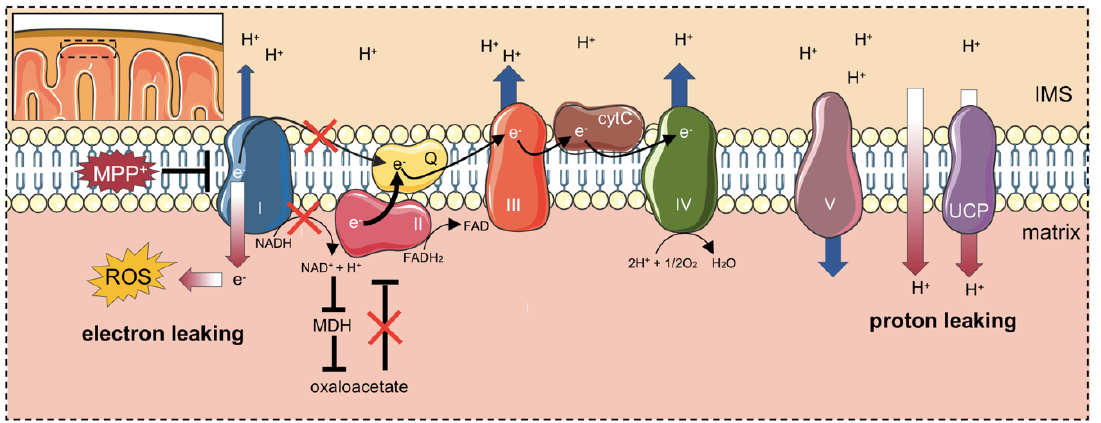
Figure 7. Proposed mechanism of MPP + toxicity at the IMM level. MPP + promotes the impairment of complex I activity. Electrons are then addressed towards other substrates, increasing ROS production (electron leaking). The reduced activity of complex I affects MDH activity as well as the accumulation of the Krebs cycle intermediates and complex II inhibitor oxaloacetate. In this perspective, the activity of complex II raises since it is less subjected to oxaloacetate inhibition. MPP + also induces UCPs gene expression. The increased activity of UCP proteins dissipates partially the proton gradients (proton leaking), a mechanism called “mild uncoupling” and aimed to counteract ROS damage. Original figure (created with https://smart.servier.com tools).